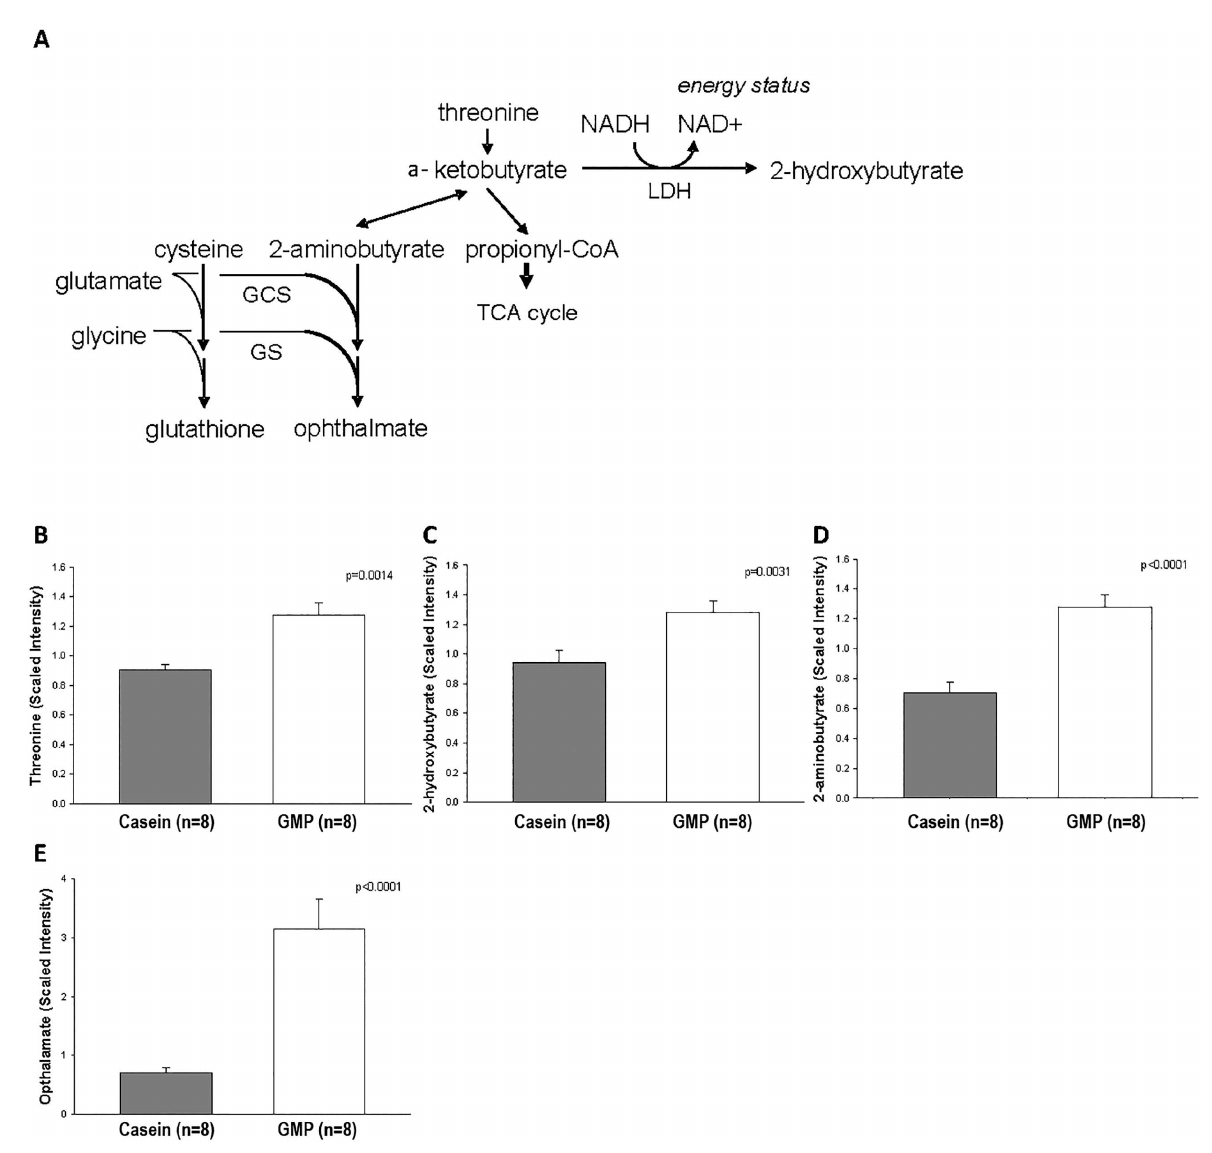
Fig 9. Liver threonine metabolites. A, metabolic pathway of threonine breakdownto its metabolites 2-aminobutyrate, propionyl-CoA, and 2-hydroxybutyrate. Mass spectrometry-scaled intensity of threonine (B), 2-hydroxybutyrate (C), 2-aminobutyrate (D), and opthalamate (E) metabolites in the livers of female mice fed the 13%-fat casein and 13%-fat GMP diets. The GMP diet significantly increased the presence of threonine, 2-hydroxybutyrate, 2-aminobutyrate, and opthalamate relative to the mice fed the casein